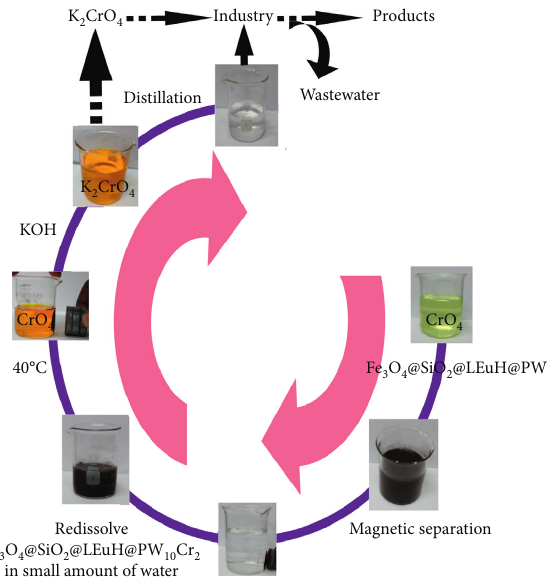
Figure 15: Schematic presentation of hexavalent chromium removal from wastewater and reusability mechanisms.